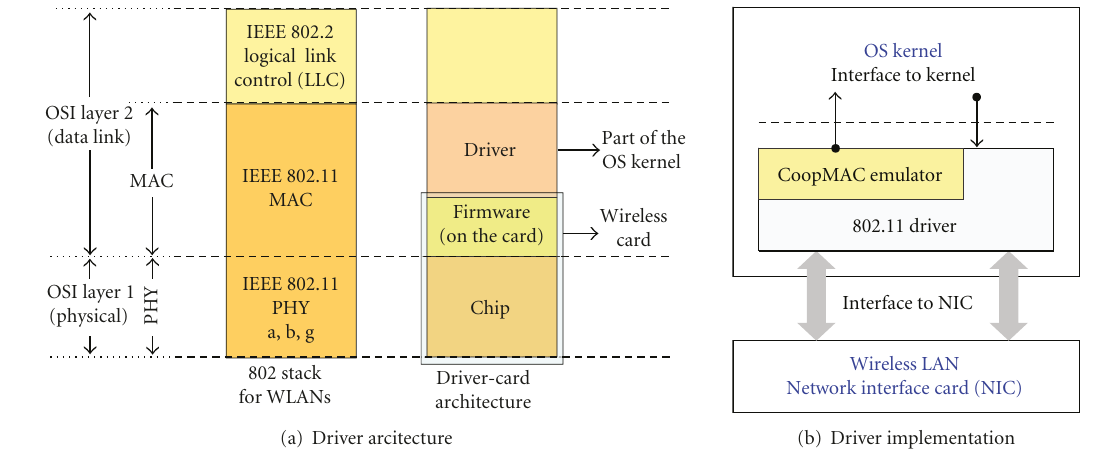
Figure 4: Driver architecture and CoopMAC